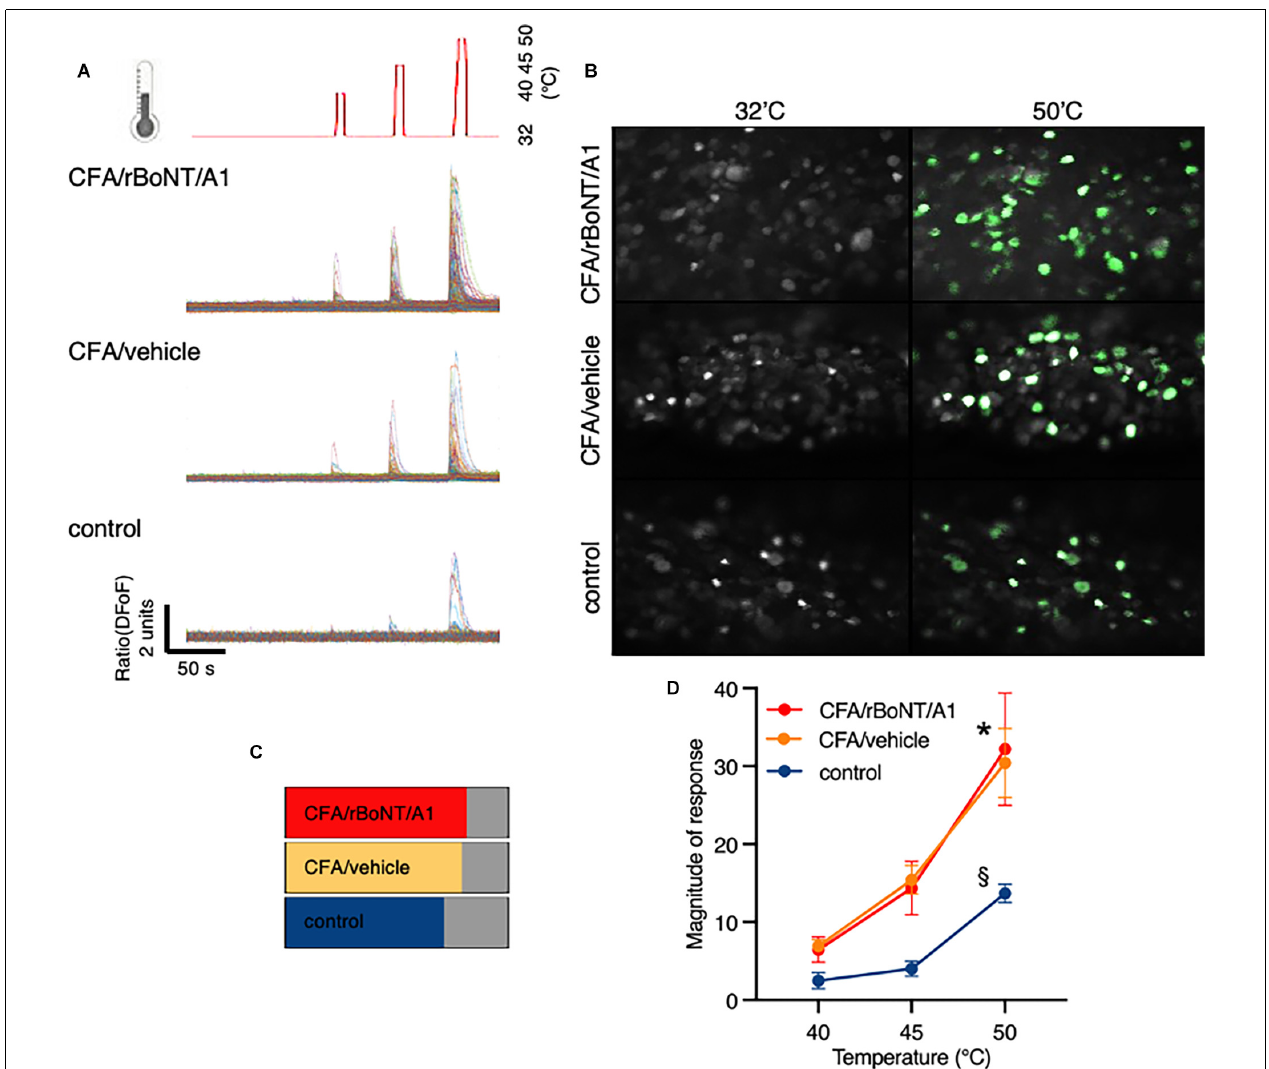
FIGURE 7 | rBoNT/A1 fails to inhibit calcium transients in the DRG upon peripheral heat stimulation. (A) Schematic drawing of the thermal stimulation protocol in line with traces below depicting calcium transients normalize to baseline ( ∆ FoF) in individual neurons from mice treated with CFA and rBoNT/A1 (top), CFA and GPB (vehicle; middle), or vehicle alone (bottom) over time. Baseline temperature was set to 32 ◦ C. To apply stimuli, heat was increased to 40 ◦ C, 45 ◦ C, and 50 ◦ C for 8 s each. In-between the stimuli, temperature returned to baseline. (B) False color images of GCaMP6s-labeled DRG neurons in situ at baseline and after noxious heat stimulation (50 ◦ C) from mice treated with CFA and rBoNT/A1 or CFA and vehicle (GPB) or vehicle alone. (C) Percentage of neurons responding to noxious heat under conditions as indicated. (D) Magnitude of responses upon heat stimulation with 40 ◦ C, 45 ◦ C, and 50 ◦ C in treatment groups as indicated. N = 4 for CFA/rBoNT/A1, n = 5 for CFA/vehicle and n = 5 for control (PBS). Mean ± SEM. Mixed-effect analysis, post hoc Tukey. p < 0.05. *(across groups): CFA plus rBoNT/A1 or vehicle vs. control; §(within groups) compared to 40 ◦